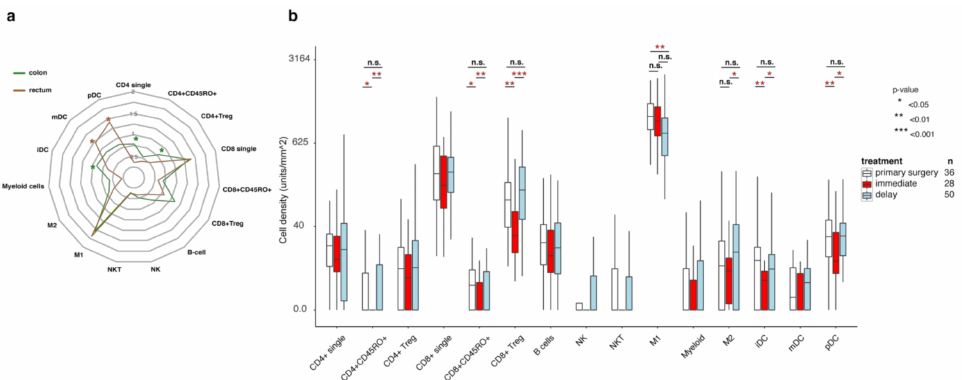
Figure 4. Immune infiltration in rectal cancers is restored after RT/CRT pre-treatment and delayed surgery, while vasculature is changed. ( a ) Radar plots of immune scores in therapy-naïve colon cancer patients (green) and rectal cancer patients (brown). ( b ) Immune infiltrate levels for patients who had primary surgery (white), radiation therapy followed by immediate surgery (<21 days), or delayed surgery after (chemo)radiotherapy. Numbers represent cell counts per mm 2 , cube root transformed. Boxes show median values and interquartile range of the ratios, whiskers represent 1.5 IQR. Wilcoxon signed-rank test with Pratt method assuming asymptotic distribution was used for statistical analysis. Statistically significant differences: * p < 0.05, ** p < 0.01 and *** p < 0.001; not statistically significant differences: